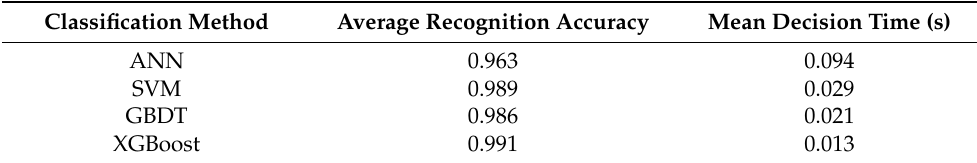
Table 5. Comparison of degradation state recognition